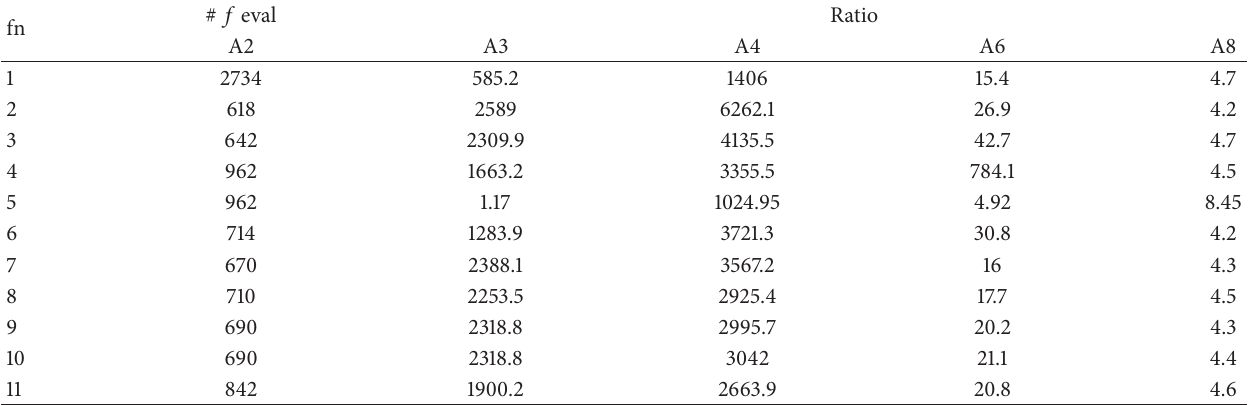
Table 5: The total number of function evaluations both 𝐹 and 𝑓 from A2 and the ratio of the number of function evaluations from A3, A6, and A8 to the number of function evaluations from A2 when 𝑛 = 10 .